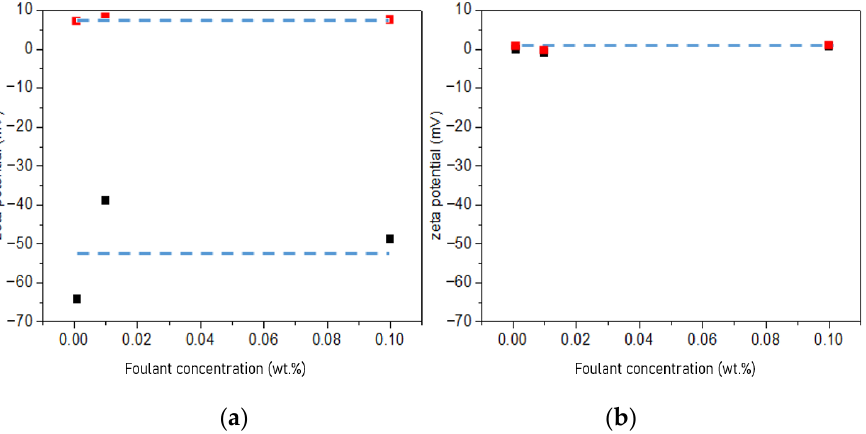
Figure 9. Zeta potential of ( a ) the 0.001, 0.01, and 0.10 wt.% cationic foulant (CPC) (red square) and the 0.001, 0.01, and 0.10 wt.% anionic foulant (SDS) (black square) in 0.513 M NaCl and ( b ) the cationic foulant (CPC) (red square) and the anionic foulant (SDS) (black square) in 2.565 M NaCl.